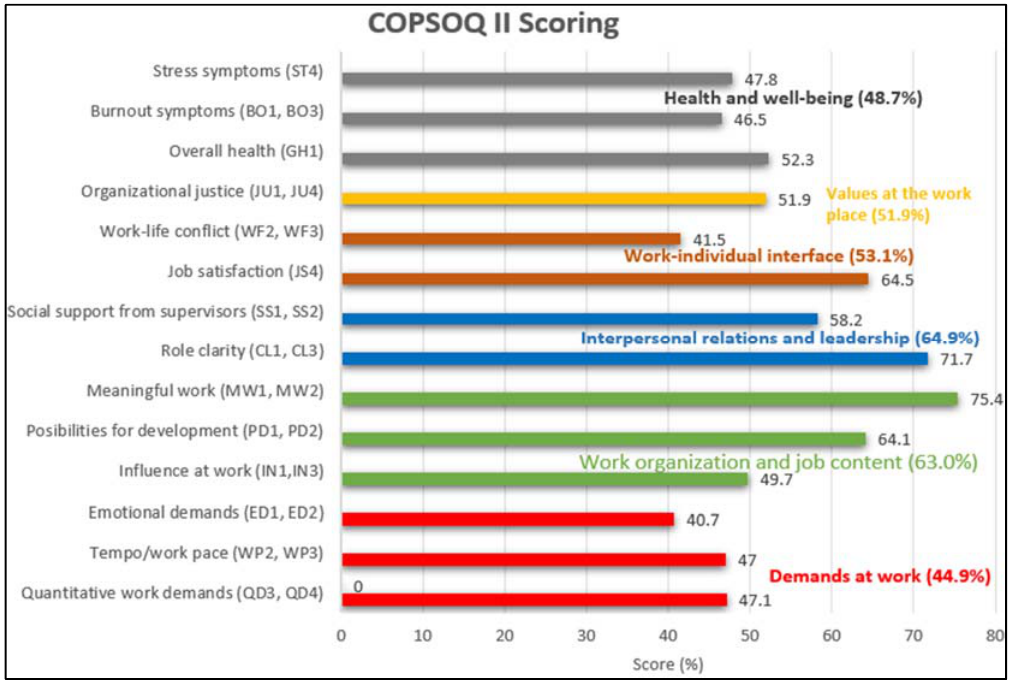
Figure 2. COPSOQ II results with 14 scales of psychosocial scoring for the nursing population.